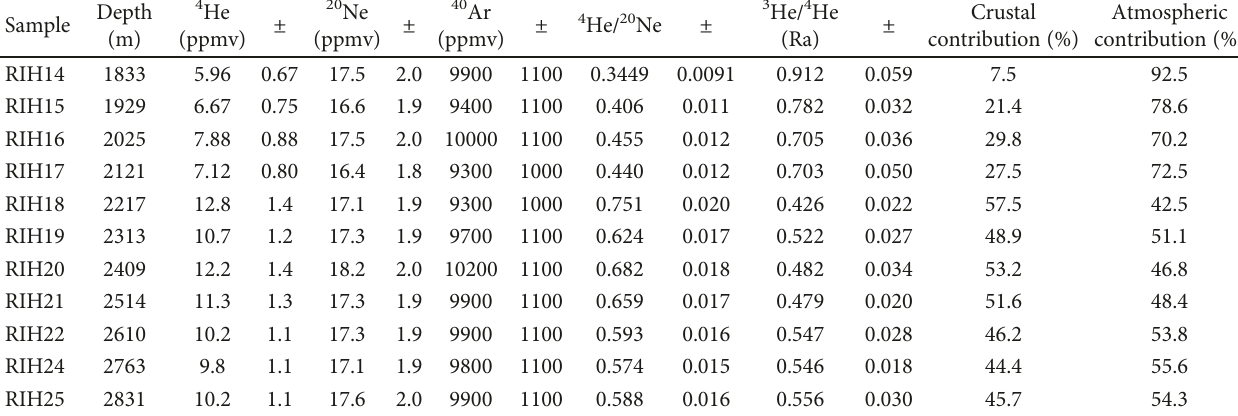
Table 2: Noble gas composition of gas samples collected during water fl ushing after core run 7/8 in the pilot hole KFD1 at Gothane, near Koyna, Western India.